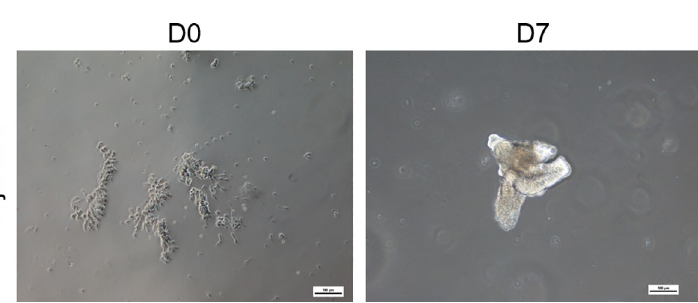
Fig 1. Intestinal porcine crypts isolated from the jejunum (D0) form 3D-organoids (D7) after a cultivation period of seven days.